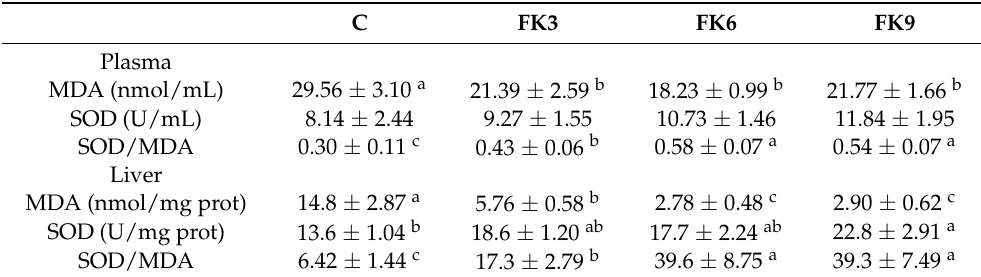
Table 8. Antioxidant response in plasma and hepatic tissue of largemouth bass fed diets with various FK levels (means ± SEM. n = 12).